Question: Briefly state, in one sentence, what is plotted here.
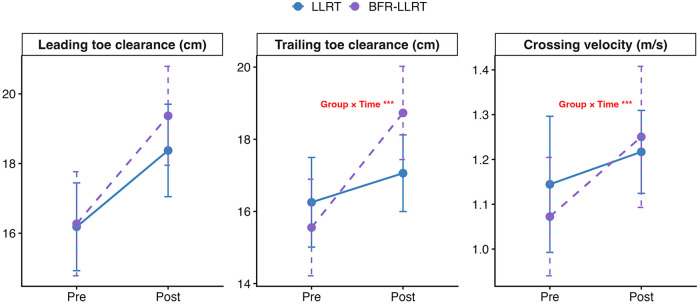
Answer: Changes in obstacle-crossing performance before and after the intervention. Panels represent leading-limb toe clearance, trailing-limb toe clearance, and crossing velocity. Data are presented as mean ± SD for the LLRT and BFR-LLRT groups. Significant group × time interactions were observed for trailing-limb toe clearance and crossing velocity, whereas the group × time interaction for leading-limb toe clearance did not reach statistical significance ( p = 0.074). Units are indicated in each panel. *** p < 0.001.